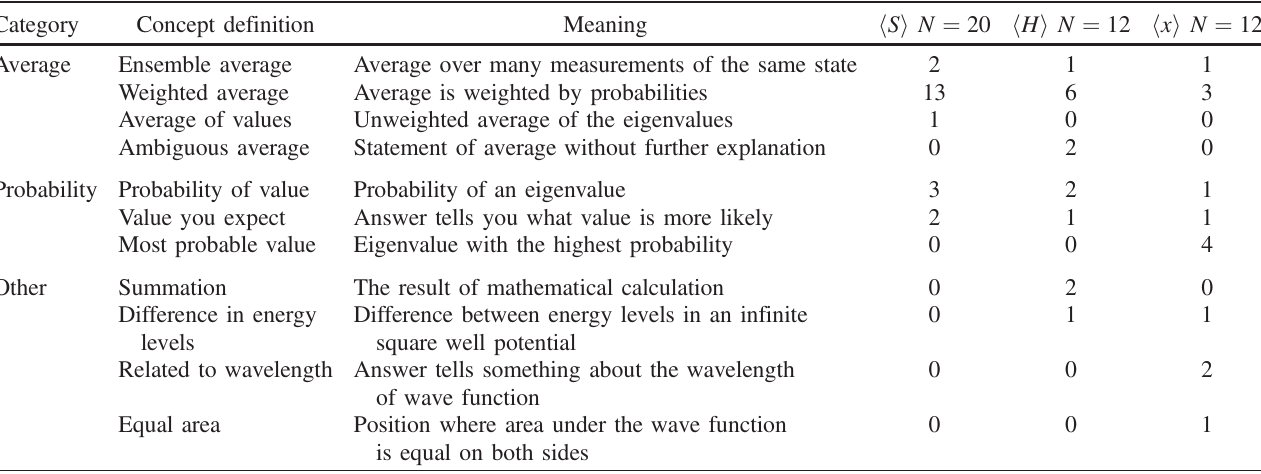
TABLE II. Concept definitions identified in the responses of all students that were interviewed. An entry of “ 0 ” implies that the concept definition did not appear in that context for any of the interviewed students. Some students were labeled with multiple concept